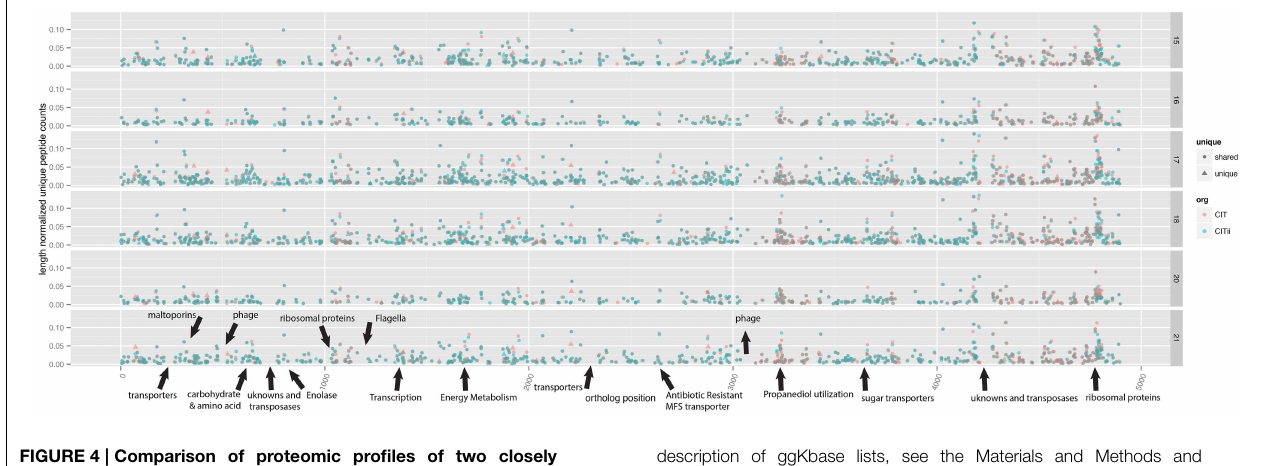
description of ggKbase lists, see the Materials and Methods and Supplemental File 1. Triangles represent genes unique to the respective strain. Annotations marked with arrows indicate features of